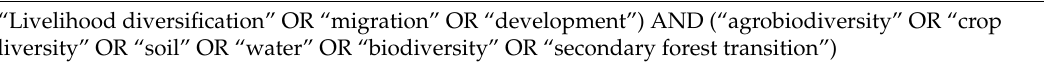
Table 1. Search terms and published sources ( N = 42) in the meta-analysis of the interactions of livelihood diversification and resource and environmental systems ( i.e. , agrobiodiversity, soils, water, wild biodiversity). Several sources address more than one resource or environmental